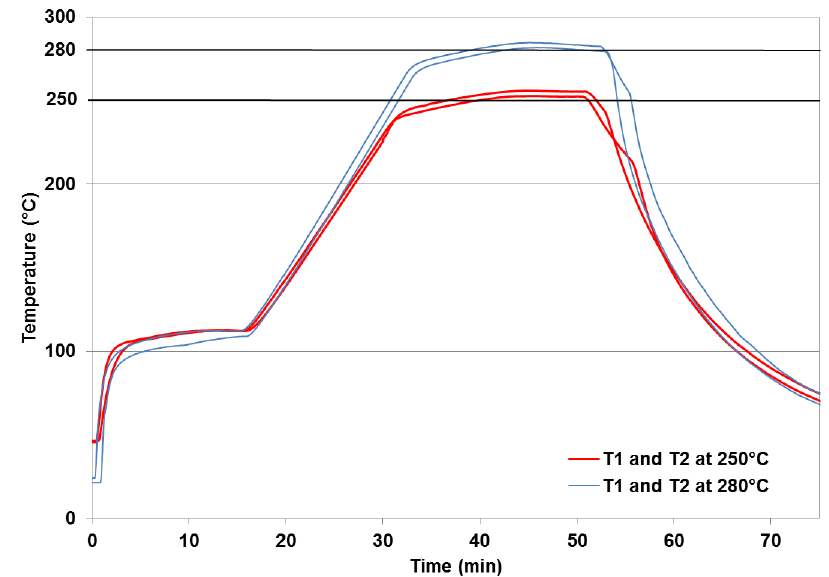
Figure 4. Temperature time profile of the bench scale